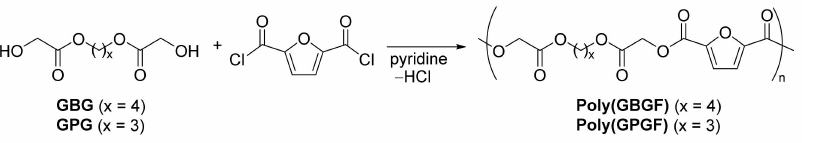
Scheme 3. Synthesis of poly(GBGF) and